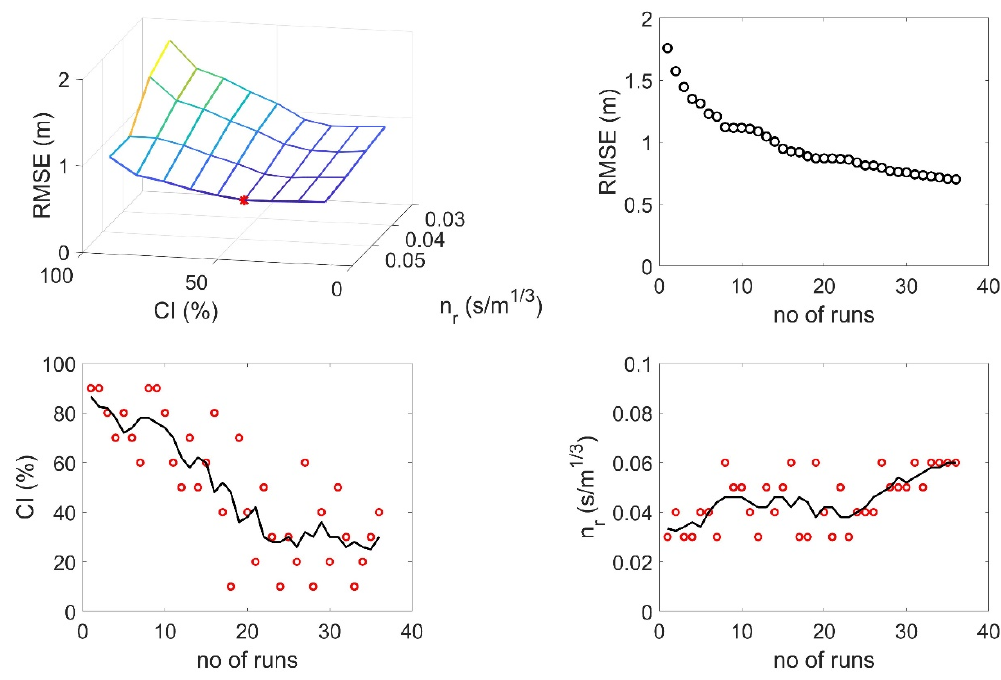
Figure 11. Dimensional space for the optimization function used for the grid-search calibration (up & left); Runs are sorted from maximum to minimum RMSE (up & right); Confidence Interval CI in respect to the run number with 5-period moving average denoted by the black line (down & left); Manning coefficient n r in respect to the run number with 5-period moving average denoted by the black line (down & right).